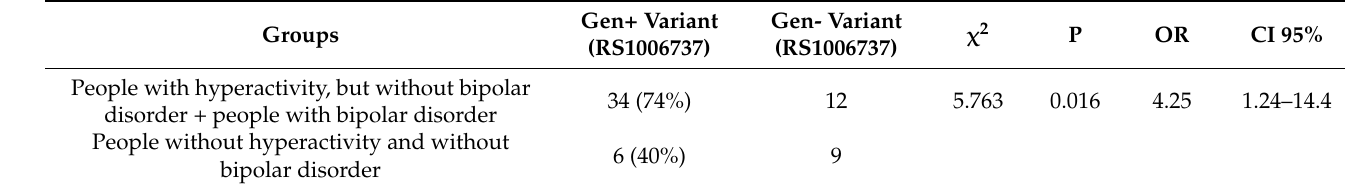
Table 3. Difference in genetic profile (variant RS1006737) in people with hyperactivity (with or without BD) plus bipolar disorders and people without hyperactivity and without bipolar